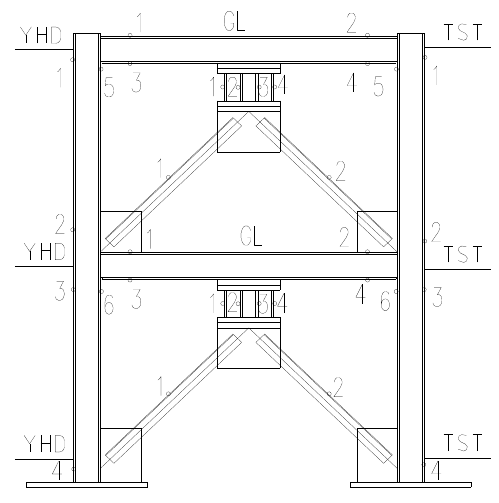
Figure 13. Layout of monitoring points.